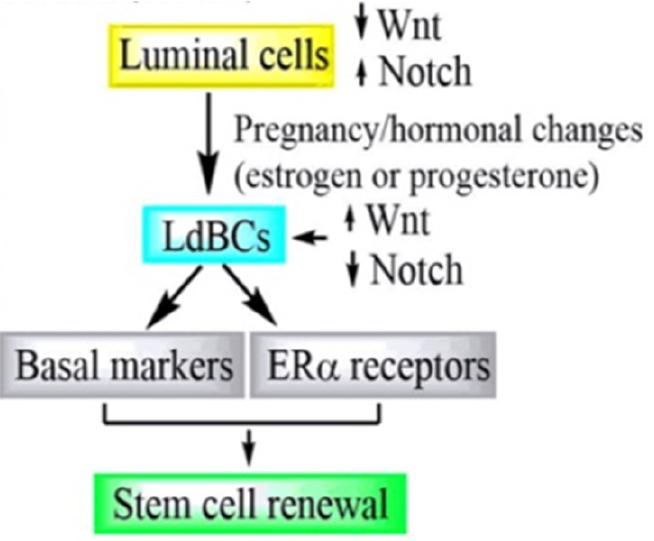
Figure 1. Sequential molecular events during self-renewal property acquisition in luminal A cells. LdBCs—Luminal-derived basal cells.